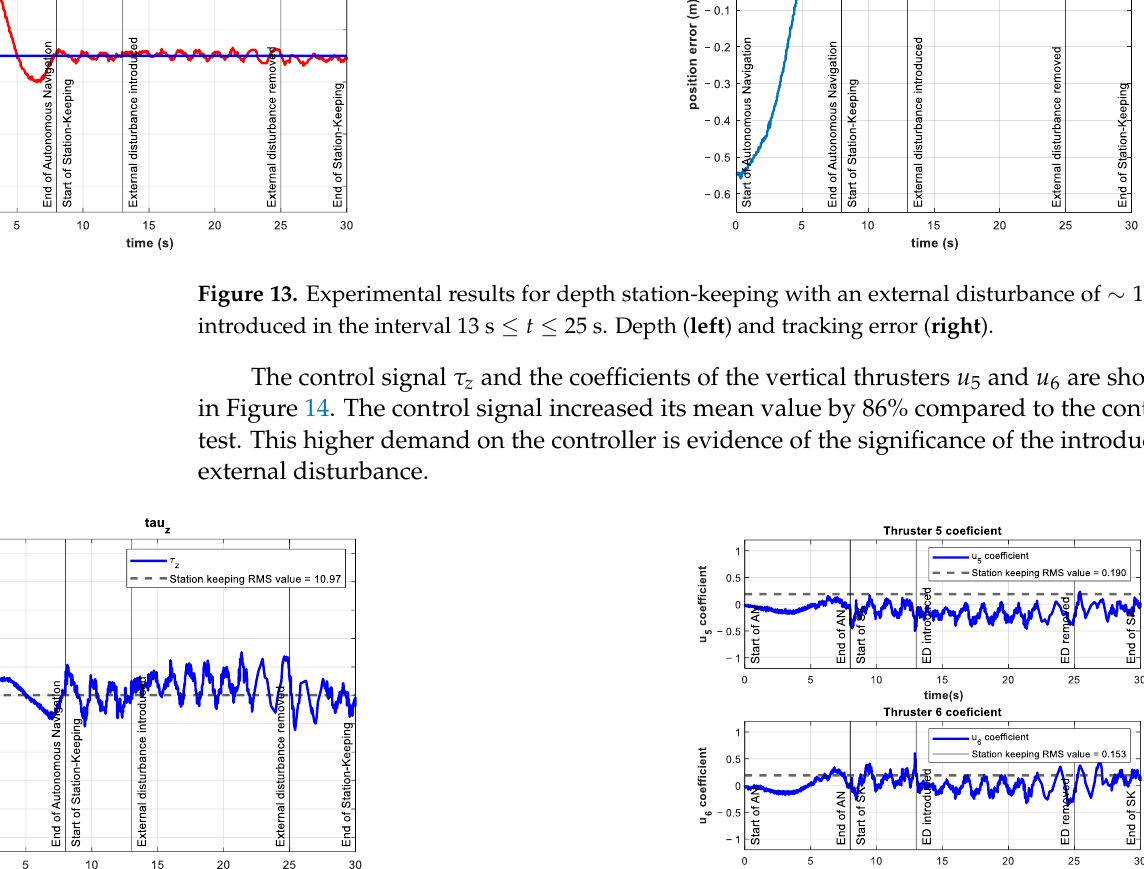
Figure 14. Experimental results for depth station-keeping with an external disturbance of ~10 N